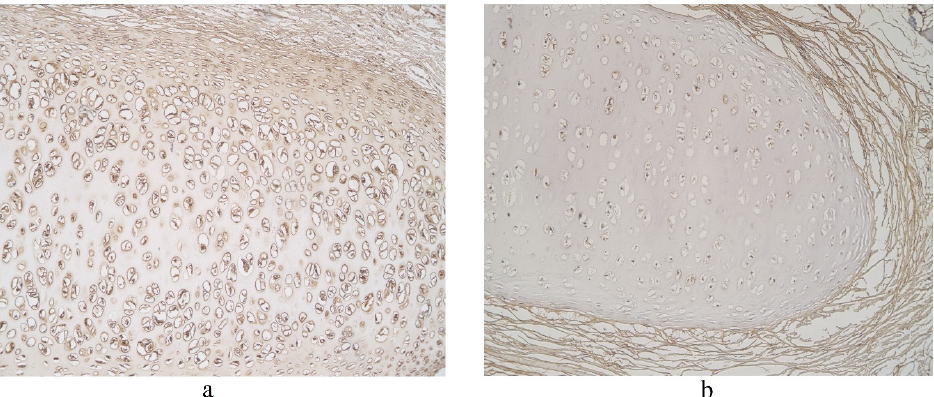
Figure 8. Note a few LL-37 positive epitheliocytes and occasional cathelicidine positive connective tissue cells of 56-year-old male. LL-37 IMH, ×250.